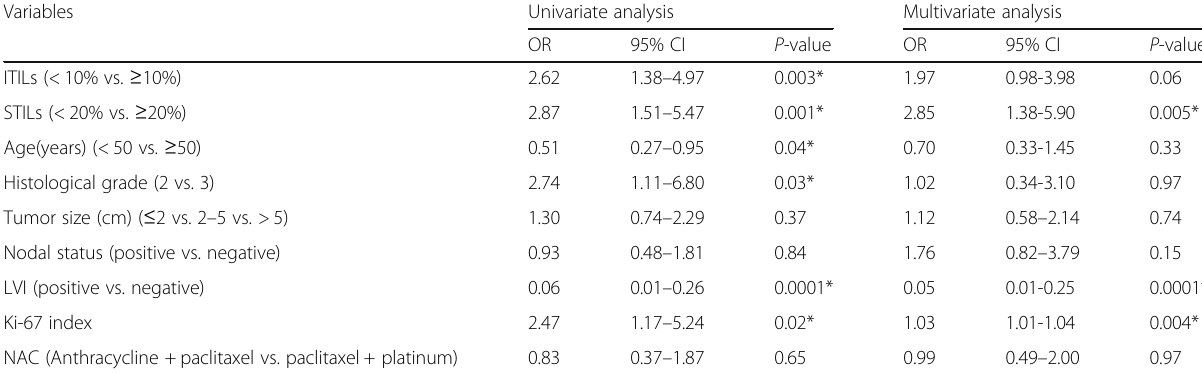
Table 6 Correlations between the optimal thresholds of TILs and pCR in neoadjuvant treated TNBCs Variables Univariate analysis Multivariate analysis